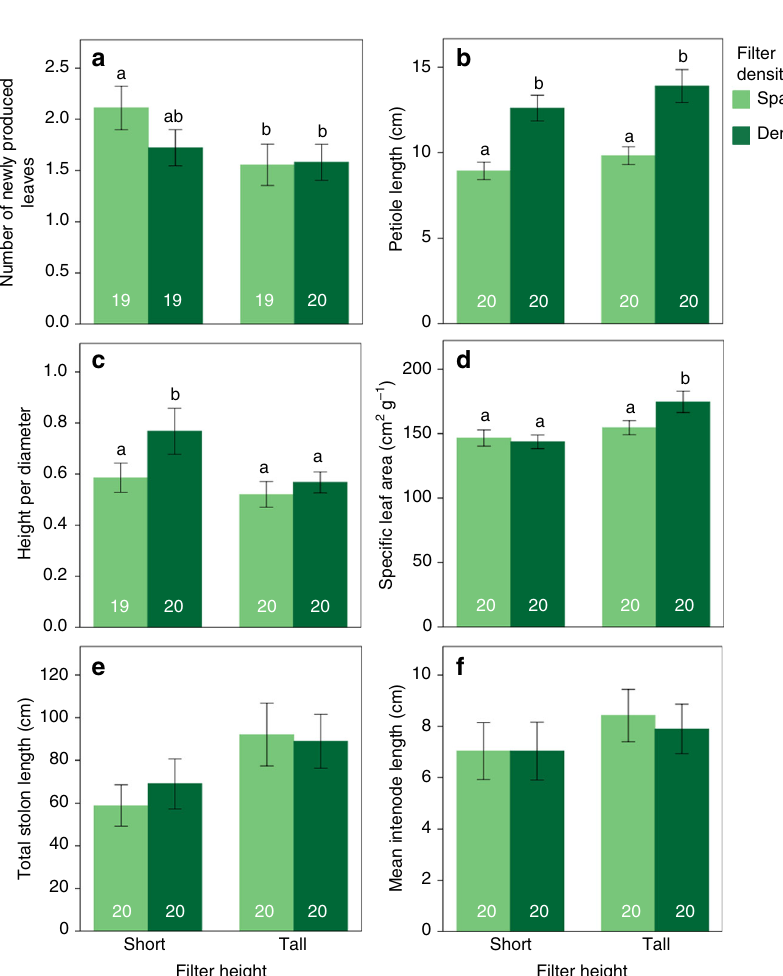
Fig. 1 Responses of P. reptans to the different treatments simulating vegetative shade. Values are mean ± SEM of number of newly produced leaves ( a ), petiole length ( b ), height-per-diameter ratio ( c ), speci fi c leaf area ( d ) total stolon length ( e ) and mean internode length ( f ) in the different treatments (sparse and dense treatments are indicated in light and dark green, respectively). Different letters indicate statistically signi fi cant differences between treatments estimated using the least signi fi cant difference (LSD) test with the false discovery rate correction 59 following generalised linear-mixed model analyses (see Table 1 for further information). Values of total stolon length are predicted values following a generalised linear-mixed model analysis with number of leaves per plant as a covariate. Sample size per treatment is indicated in